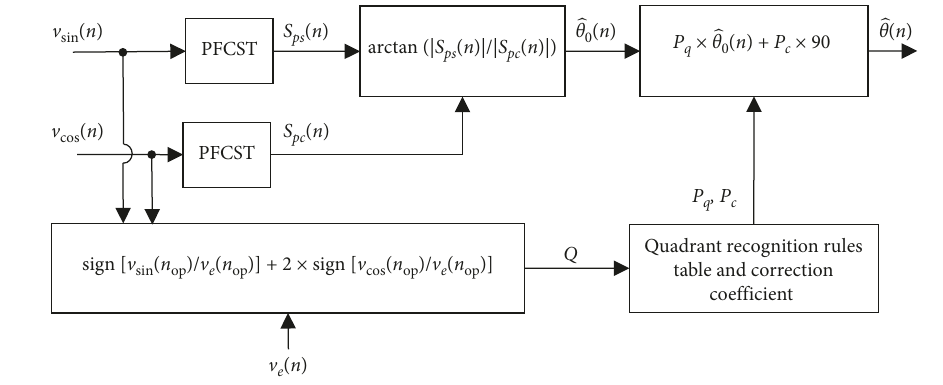
Figure 3: Block diagram of PFCST-based RDC.